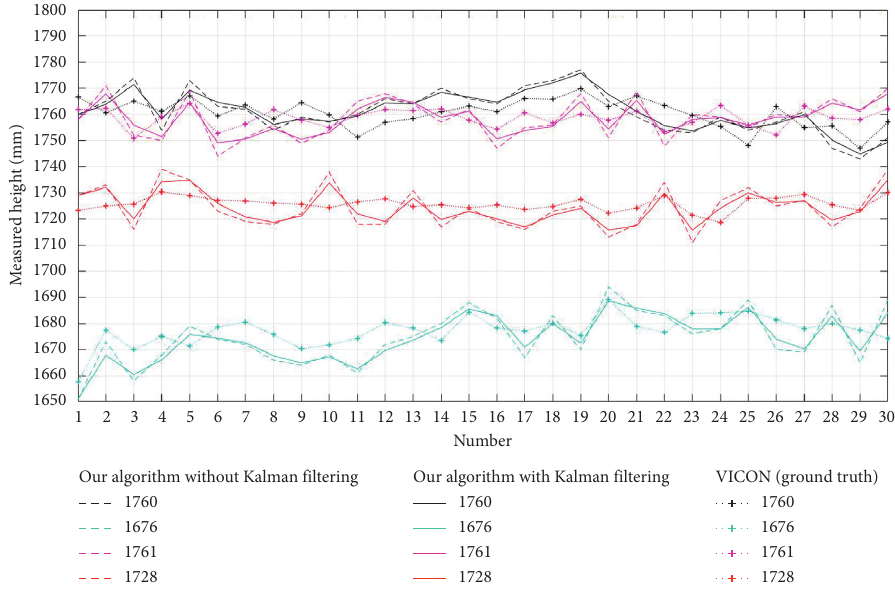
Figure 9: Experimental results of men with different heights in the six consecutive